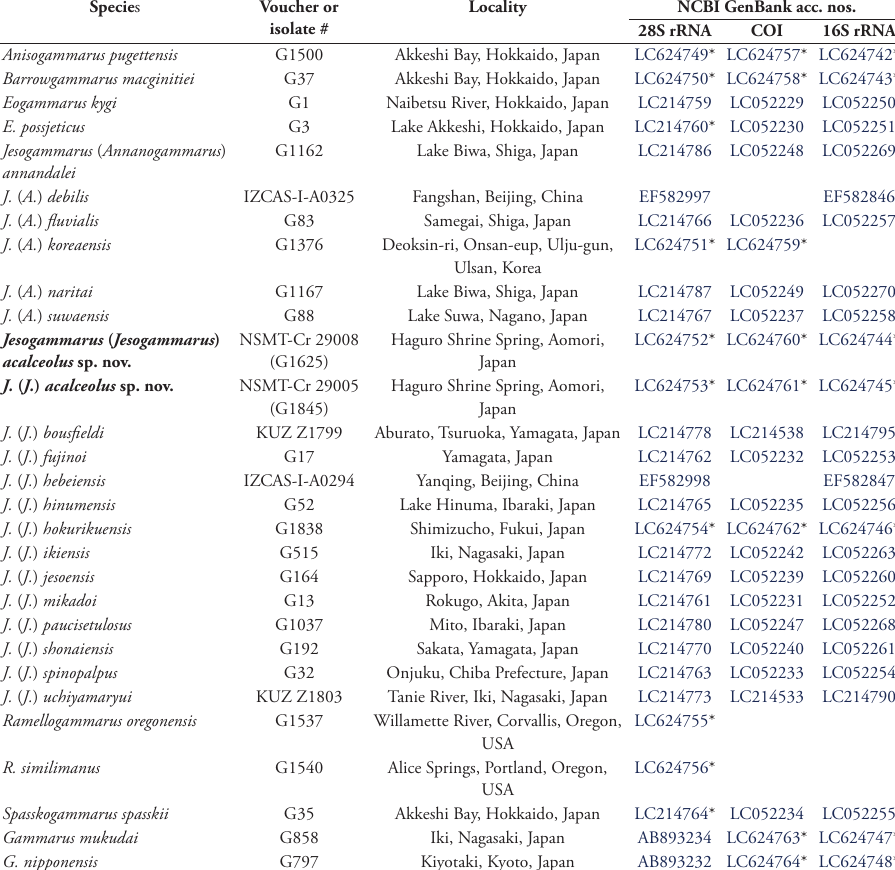
Table 1. Samples used for molecular analyses with voucher/isolate number, collection locality, and NCBI GenBank accession number. Sequences marked with an asterisk (*) were obtained for the first time in this study. Specie